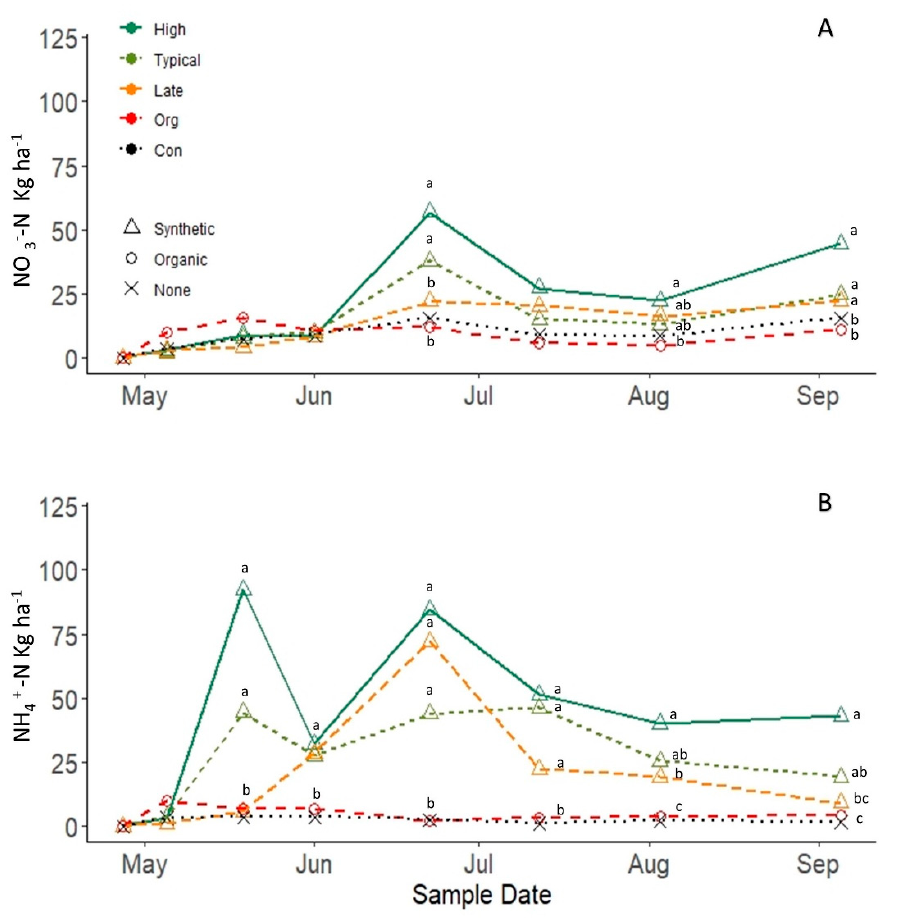
Figure 4. Average soil nitrate (NO 3 − -N) ( A ) and average soil ammonium (NH 4 + -N) ( B ) at the 0–15 cm depth during the 2016 growing season on the controlled plot-scale experiment. Triangles indicate synthetic fertilizer; open circles are organic fertilizers and X symbols no amendments. Results are means of four replicates and different letters indicate significant differences ( p < 0.05).